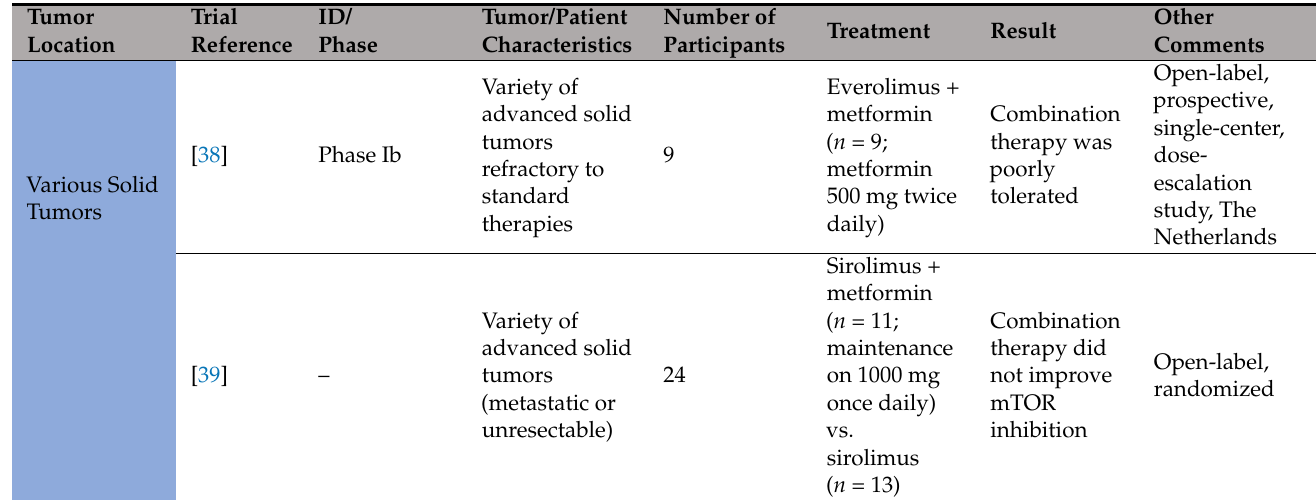
Table 2. Recent clinical trials investigating oral metformin use in cancers [11–48]. N/A: not applica- ble.